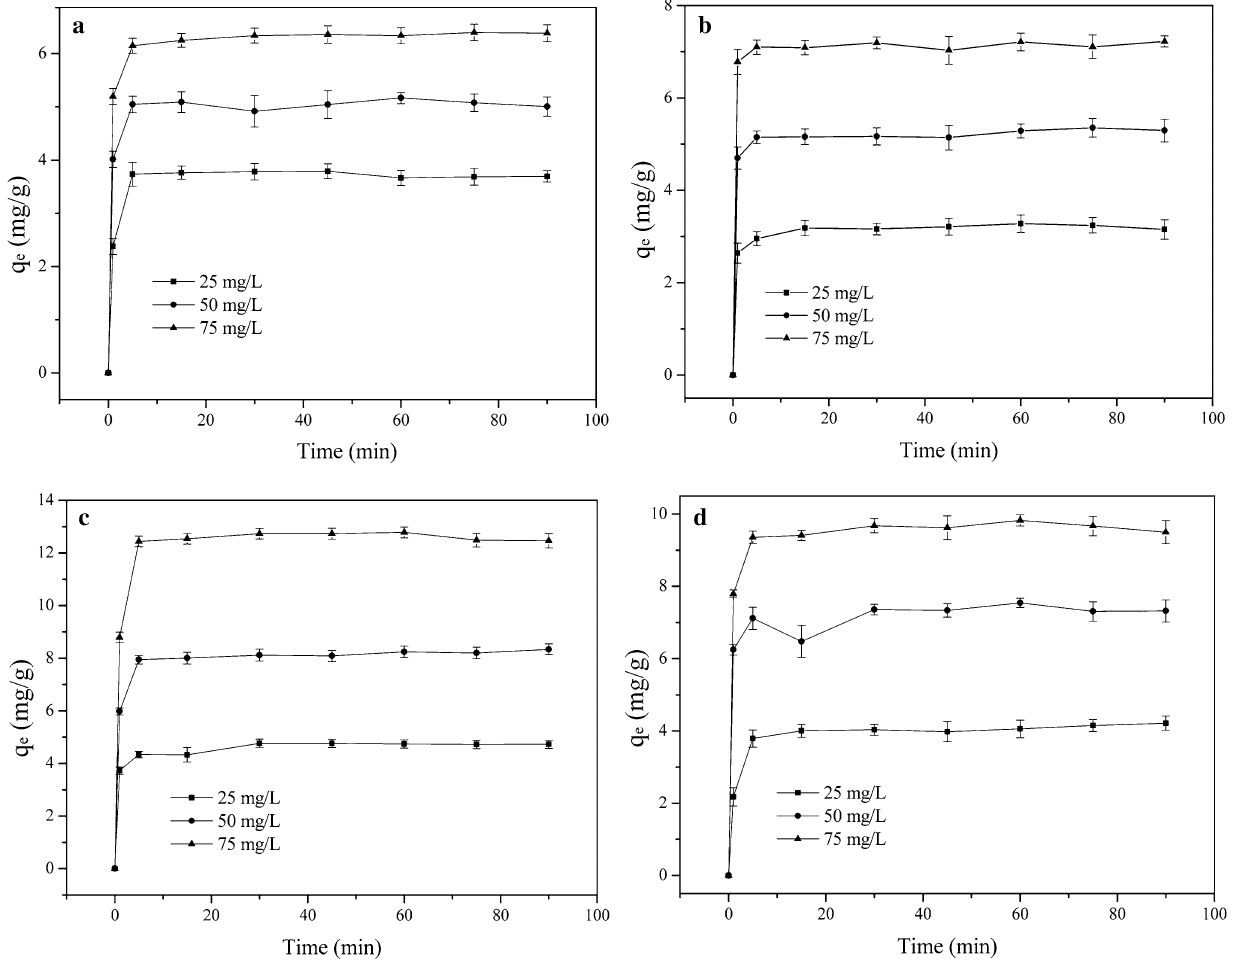
Fig. 3 Influence of contact time and initial chromium concentration on the removal efficiency of a NDP, b NBP, c DP-NFe 0 , d BP-nFe 0 (pH: 2, adsorbent: 0.05 g/L, 25 °C temperature and 250 rpm agitation speed). Error bars represent the standard deviation of the